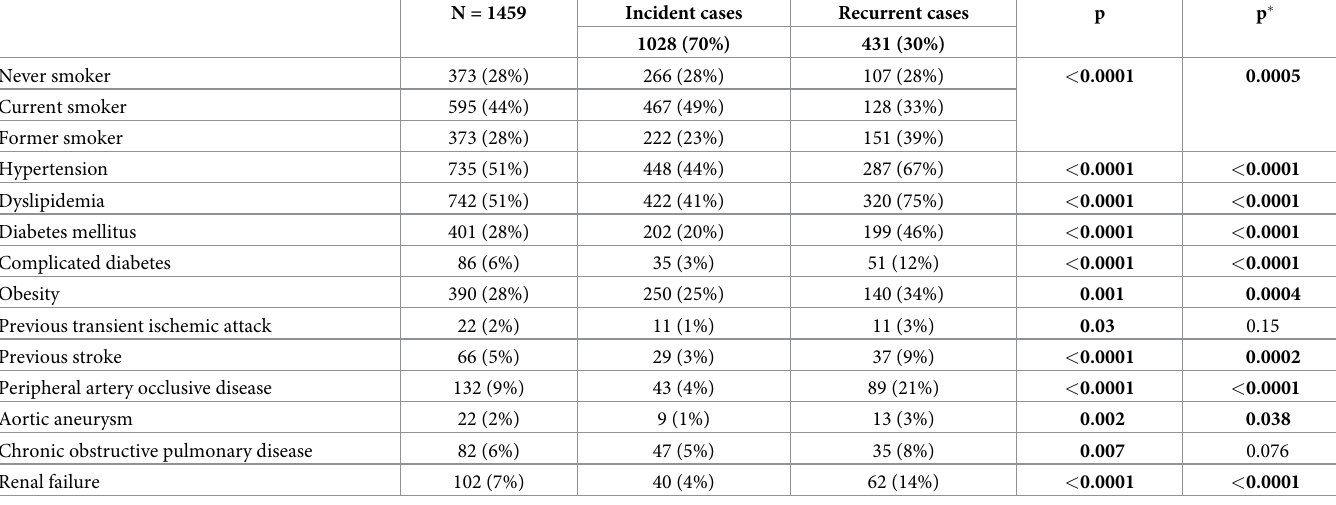
Table 2. Risk factors and comorbidities in patients admitted to hospital for an incident or recurrent acute coronary syndrome.